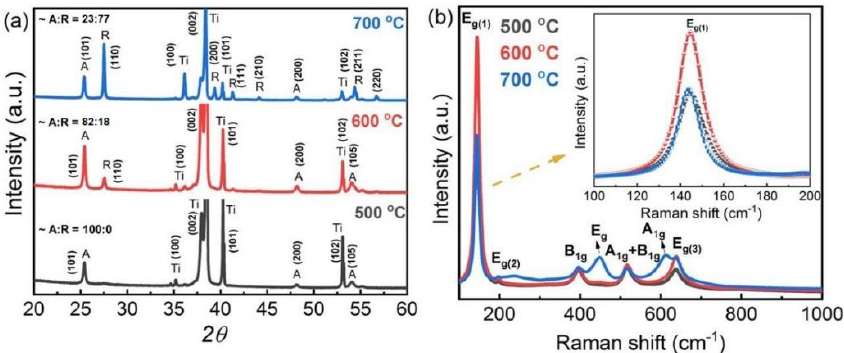
Figure 2. ( a ) X-ray diffraction patterns and ( b ) Raman spectra of TiO 2 nanotubes annealed at different temperatures. (inset) An enlarged view of the Raman E g(1) peak.